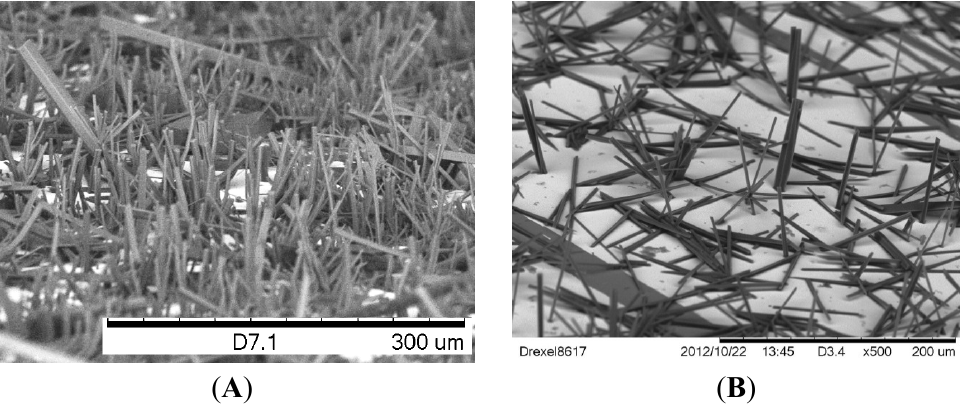
Figure 1. Scanning electron micrographs (SEM) images of ( A ) dense Cu(BTC)·3H 2 O nanopillar array and ( B ) dense Zn(ADC)·DMSO nanopillars grown on gold substrates. Samples were prepared by mixing a saturated BTC in water or ADC in DMSO solutions along with 30 mM CuSO 4 ·5H 2 O or 30 mM Zn(NO 3 ) 2 ·6H 2 O, respectively, in equal volume